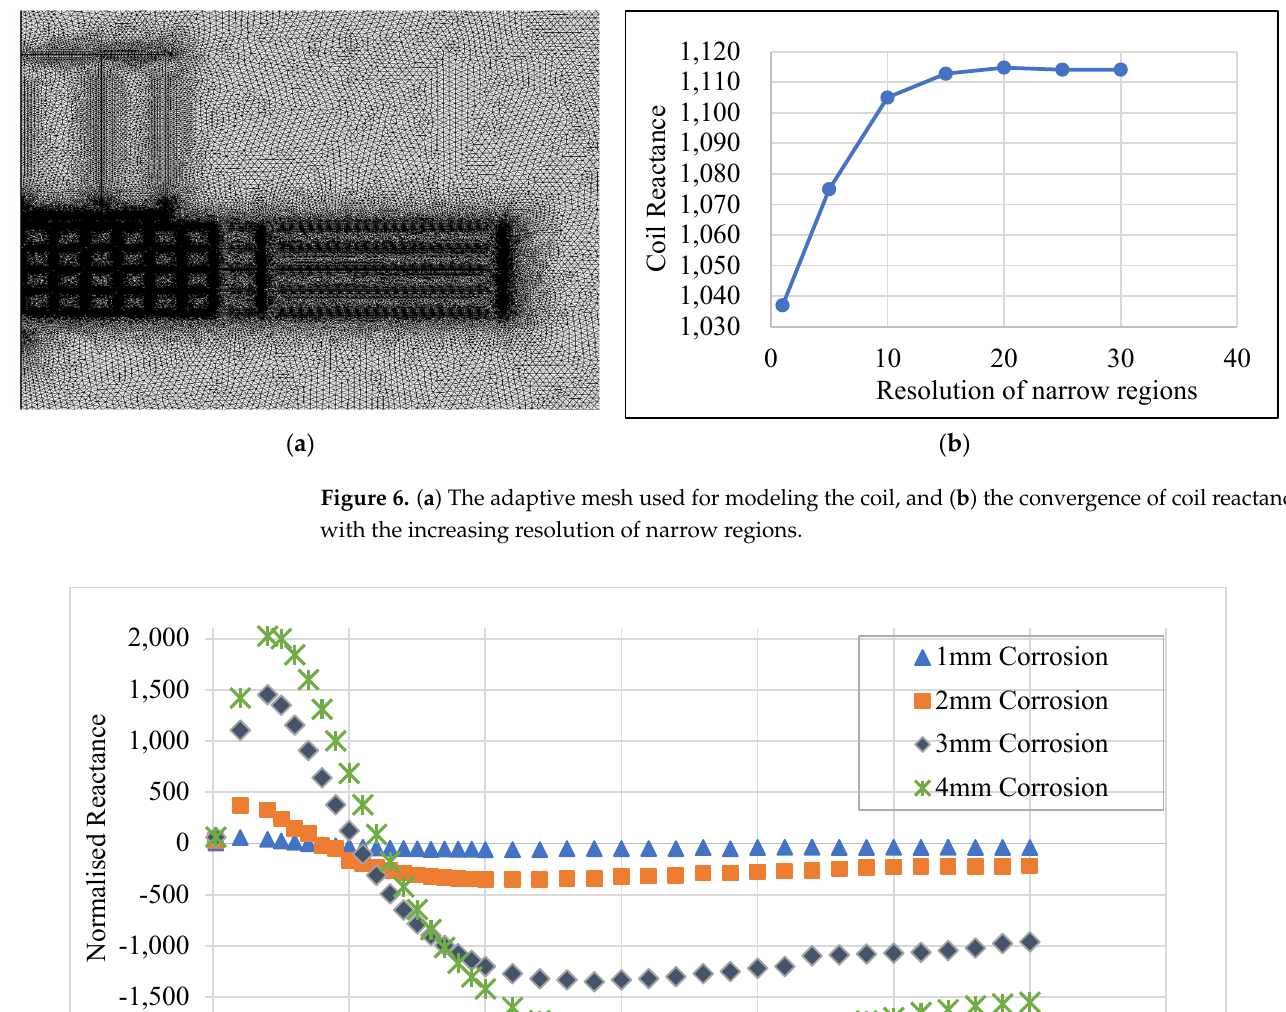
Table 4. The mesh parameters obtained from mesh convergence study.